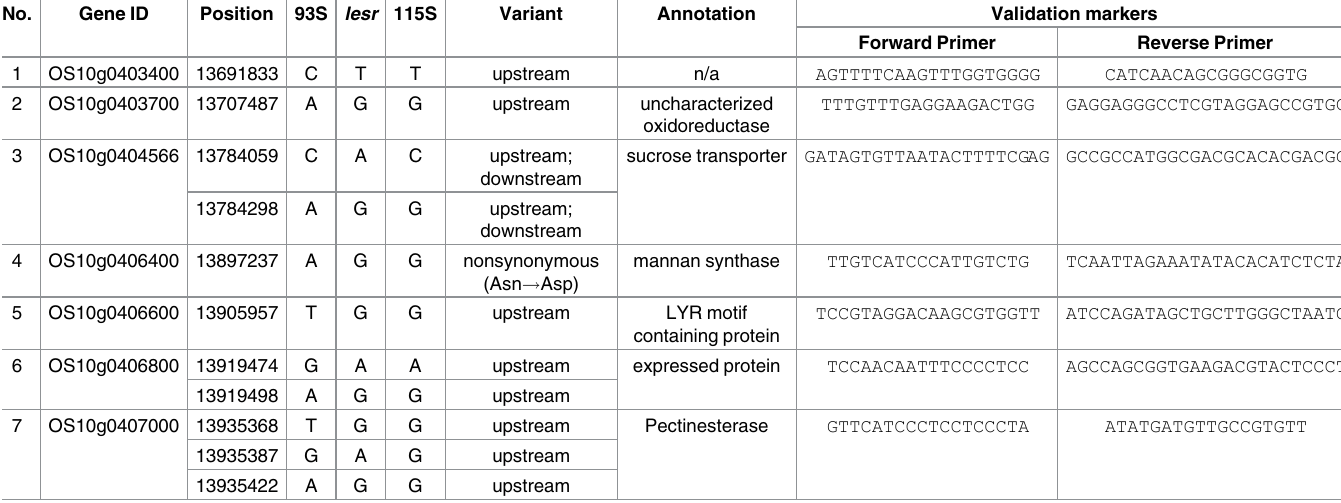
Table 4. The difference between 93S and lesr in the localization interval and validation of candidate genes’ markers.